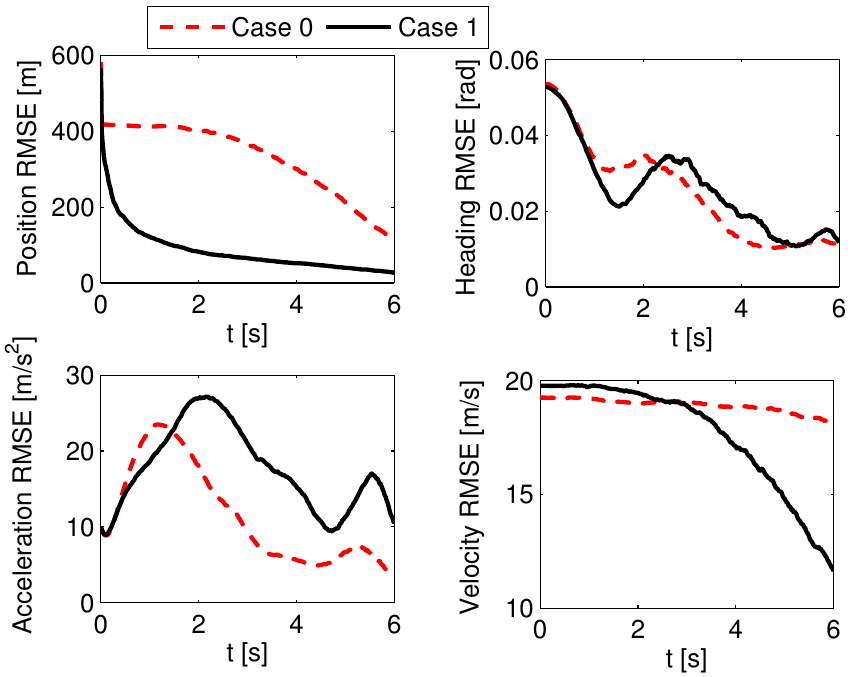
Figure 11. Estimation RMSE of the sMME-SRCKF in Case 0 and Case